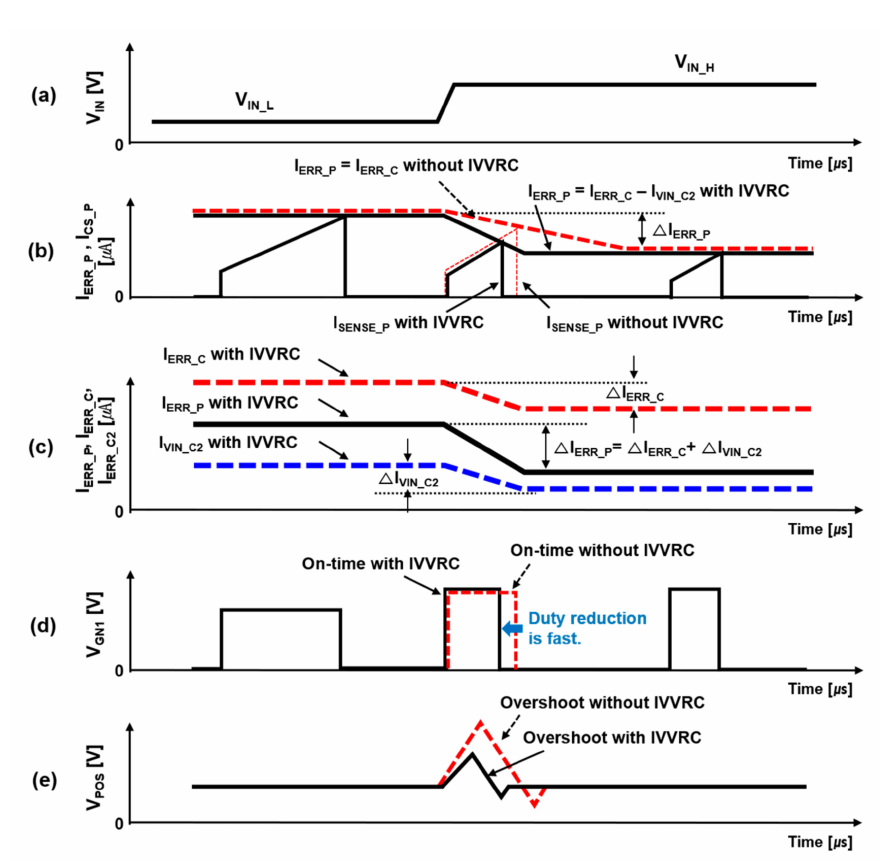
Figure 3. Timing diagrams of the IVVRC circuit: ( a ) V IN ; ( b ) I ERR_P and I CS_P ; ( c ) I ERR_P , I ERR_C1 , and I ERR_C2 ; ( d ) V GN1 ; ( e ) V POS